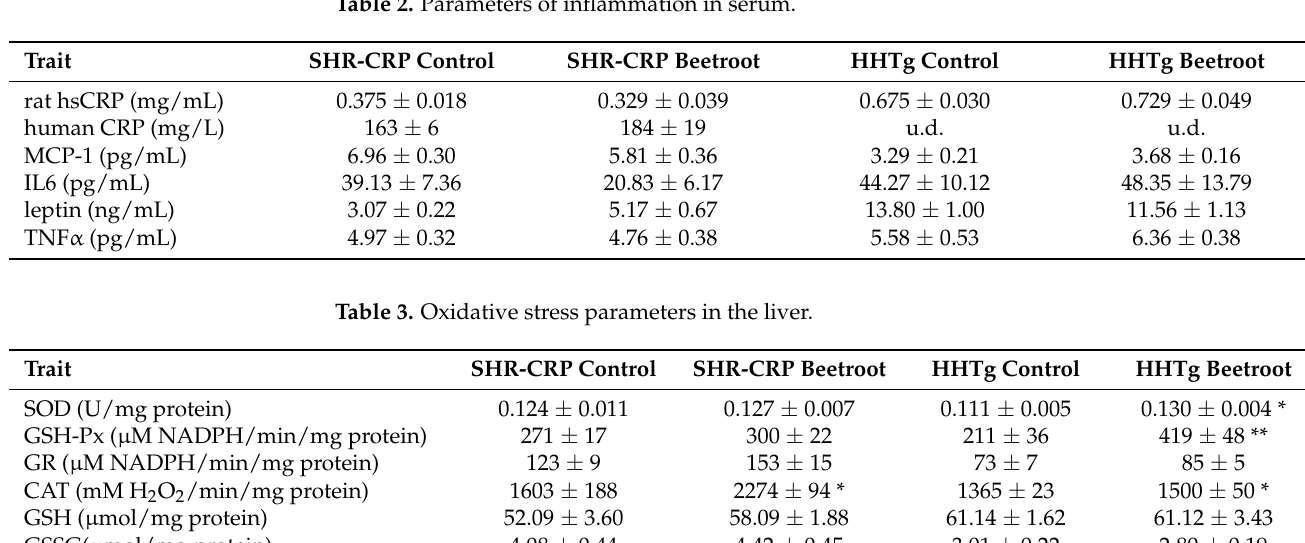
Table 2. Parameters of inflammation in serum.